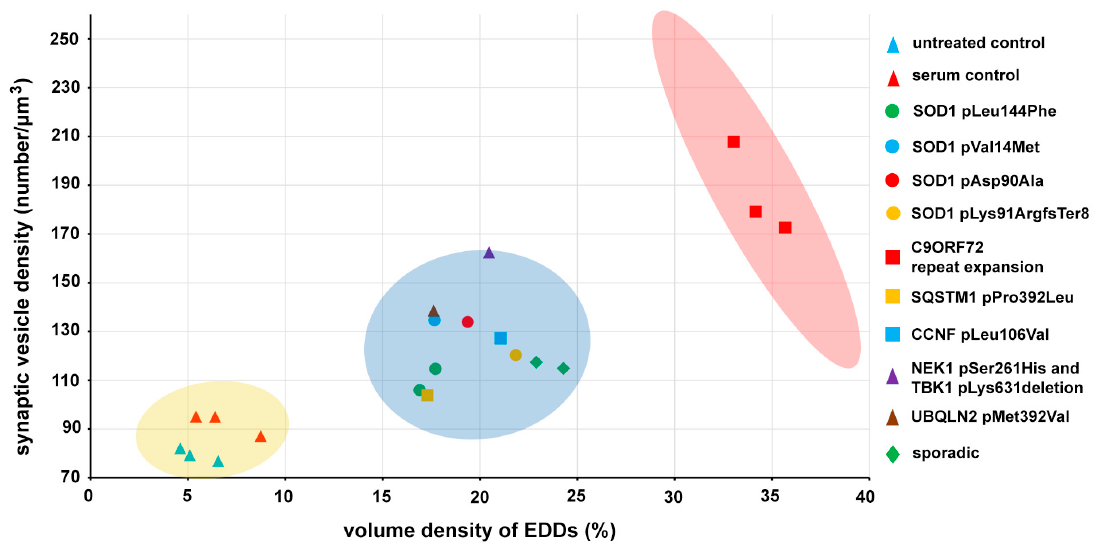
Figure 6. The active zone synaptic vesicle density is plotted against the volume density of the calcium- containing electron-dense deposits (EDDs). Since all amyotrophic lateral sclerosis (ALS) sera treatments resulted in a mutual increase in calcium levels and the density of synaptic vesicles, their combined values could form new groups (blue ellipse) separated from controls (yellow ellipse). The points representing the patients with the chromosome 9 open reading frame 72 (C9ORF72) mutation were sorted into a stand-alone cluster (represented by the red ellipse), and this group is beyond the 99.5% confidence regions of the control and the ALS groups represented by the covered area of the yellow and blue confidence ellipses.